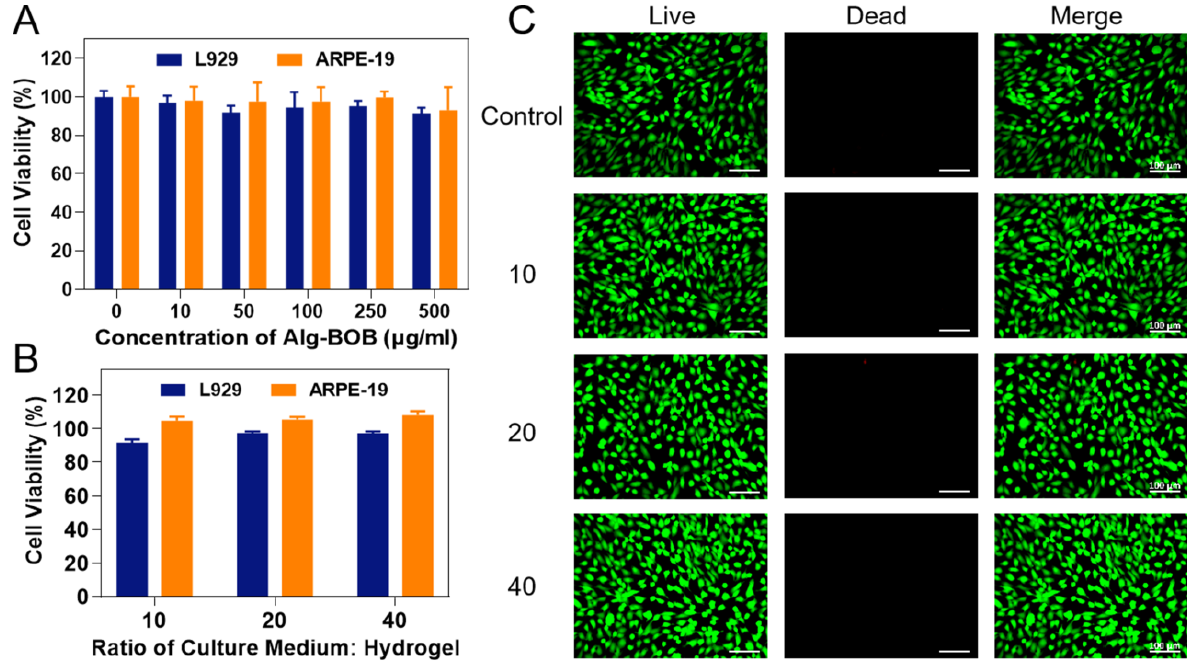
Figure 5. ( A ) Cell viability of L929 and ARPE-19 cell lines after co-incubation with Alg-BOB polymer solution for 48 h ( n = 6). ( B ) Cell viability of L929 and ARPE-19 cell lines after co-culture with hydrogel extracts which were made by changing the ratio of culture medium: hydrogel ( n = 5). ( C ) Live/Dead assay (green and red dots mean living and dead cells, respectively) of ARPE-19 cells cultured with gel extracts with different ratios of culture medium: hydrogel (10, 20, and 40, respectively). Scale bar = 100 μ m.